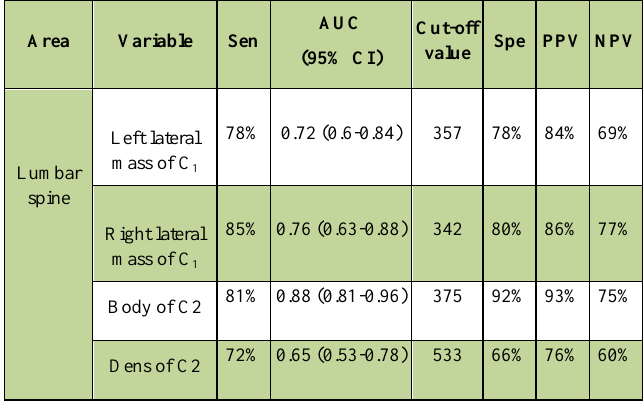
Table 2- The values of RD calculated for the three studied groups [presented as mean ± standard deviation]